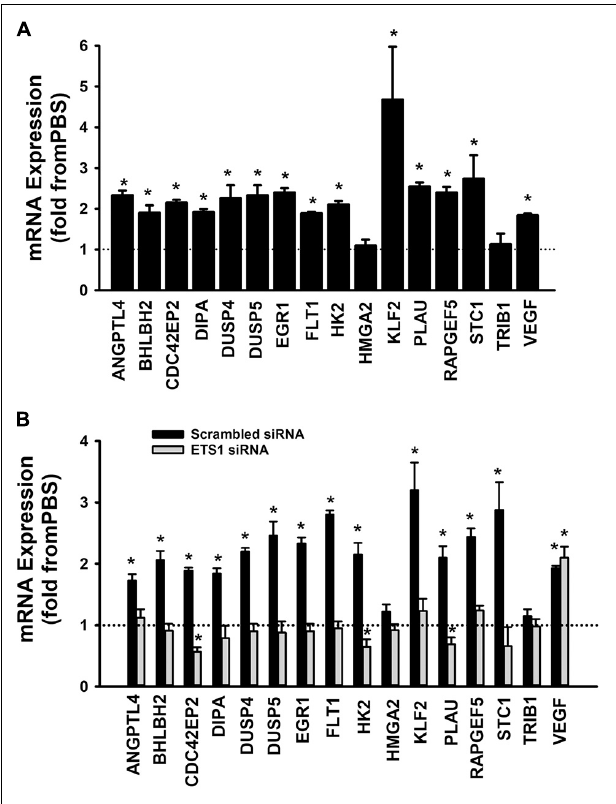
FIGURE 9 | Contribution of ETS1 to Ang-1-induced gene expression. (A) Effects of Ang-1 (300 ng/ml) on mRNA expressions of various genes in HUVECs. Cells maintained in basic medium containing PBS or Ang-1 for 4 h. Values are means ± SEM, expressed as fold from PBS. * P < 0.05, compared to PBS. N = 8 per group. (B) Effects of Ang-1 (300 ng/ml) on mRNA expressions of various genes in HUVECs transfected with scrambled or ETS1 siRNA oligos. Cells maintained in basic medium containing PBS or Ang-1 for 4 h. Values are means ± SEM, expressed as fold from PBS. * P < 0.05, compared to PBS. N = 8 per